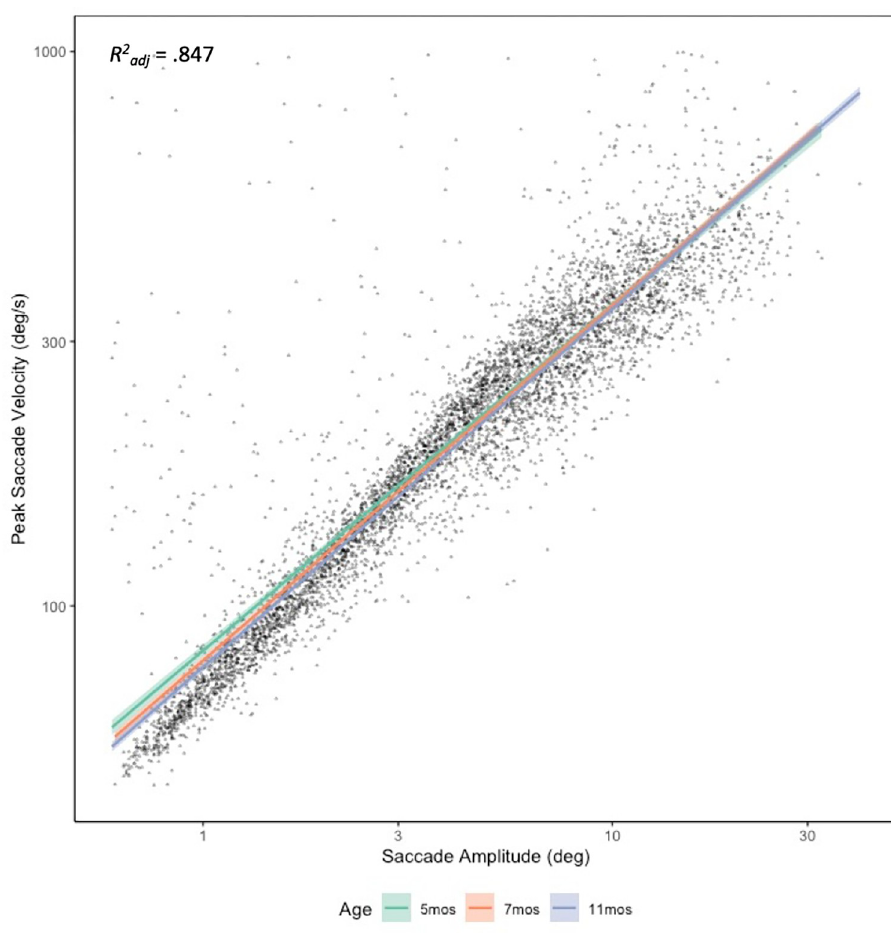
Fig 5. Main sequence and linear regression lines by age. Dots indicate individual observations with peak saccade velocities < 1000 degrees/second and amplitudes > .5 degrees. Shading indicates 95% confidence interval.